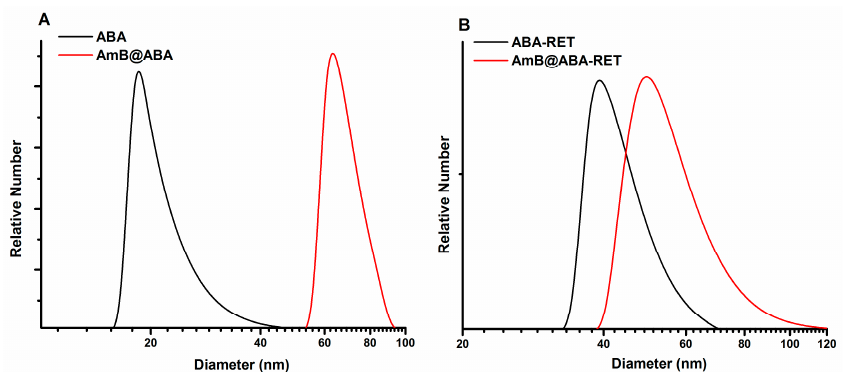
Figure 4. Diameter distributions of empty micelles and AmB@PMS obtained from ABA ( A ) and ABA-RET ( B ) copolymers.